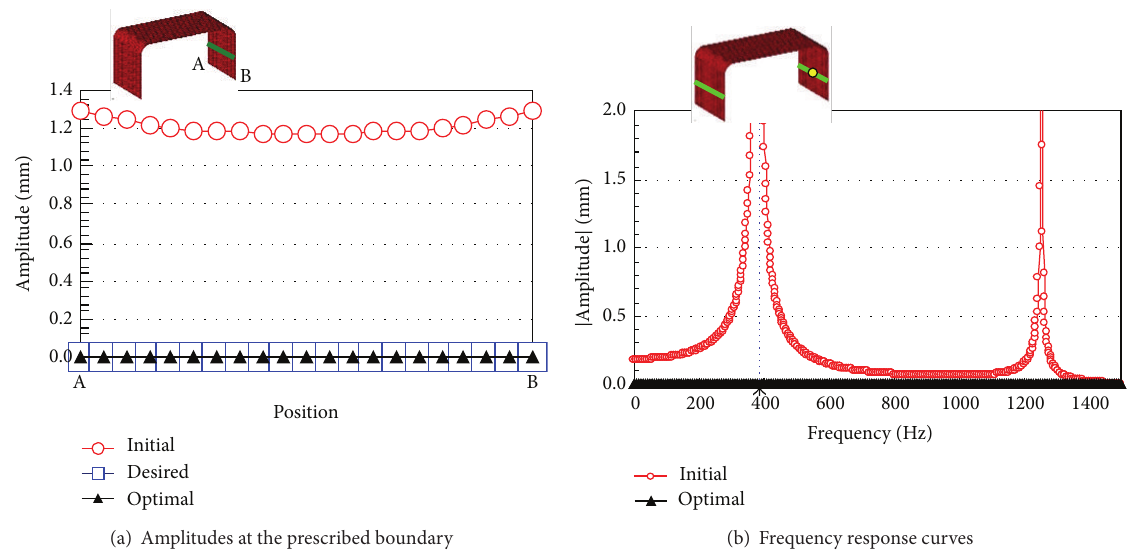
Figure 11: Comparison of amplitude distributions and frequency responses (table-shaped